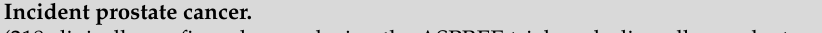
Table 2. Multivariable Cox regression model for prostate cancer